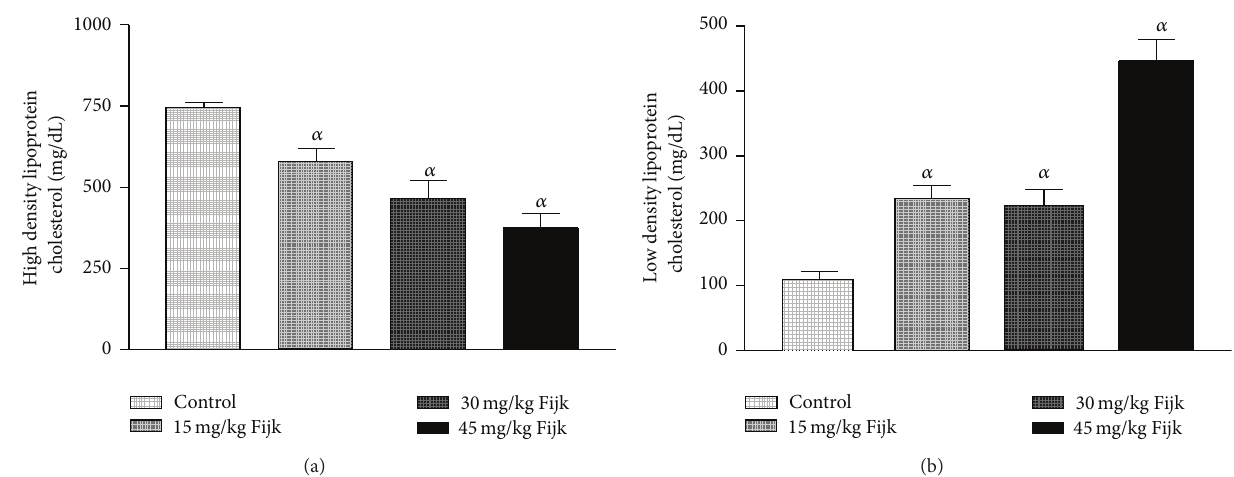
Figure 3: (a) Level of rat plasma high density lipoprotein-cholesterol following repeated and oral exposure to Fijk herbal at different dosages; (b) level of rat plasma low density lipoprotein-cholesterol following repeated and oral exposure to Fijk herbal at different dosages. Data are presented as mean value ± standard error of mean (SEM), 𝑛 = 6 . 𝛼 is significant at 𝑃 < 0.05 relative to control. 0.00.51.01.5